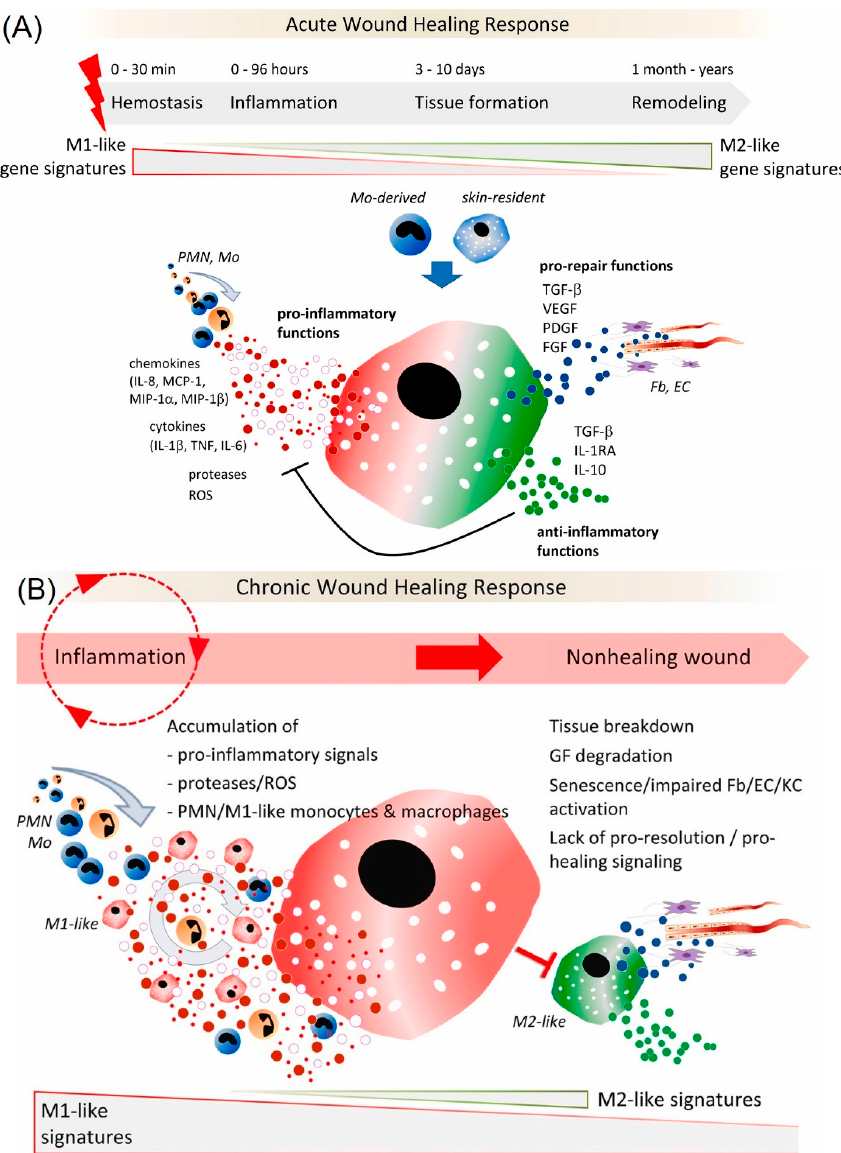
Figure 2. ( A ) Role of macrophages in an acute wound healing response; ( B ) Dysregulated activation of macrophages in chronic wounds. Reprinted from Ref. [26].